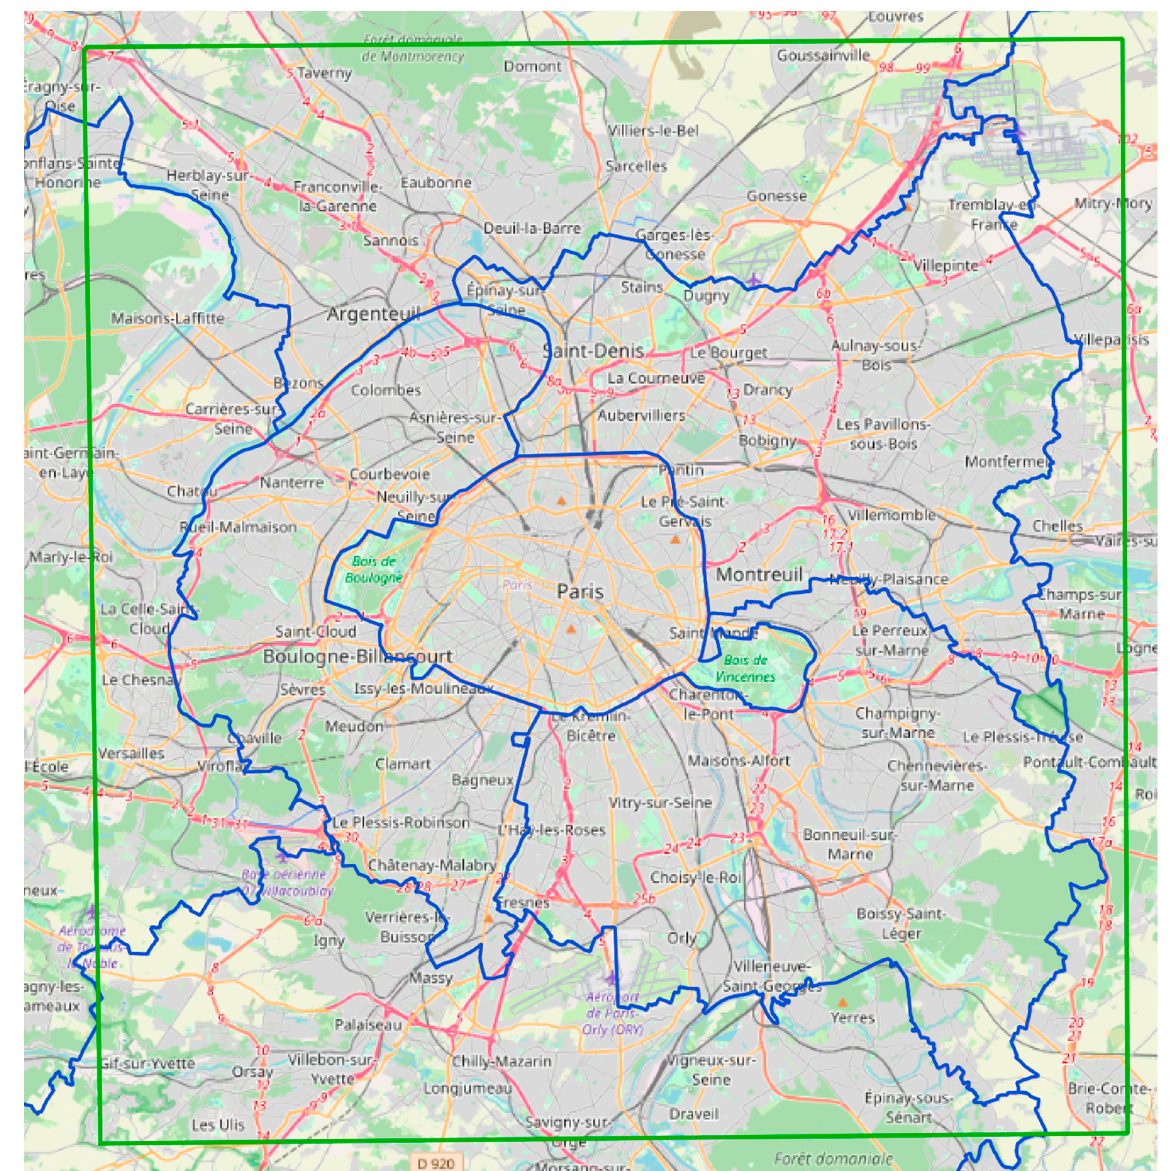
Figure 2. View of the domain boundaries (green line) and the department boundaries (blue line) (© OpenStreetMap Con- Figure 2. Viewofthedomainboundaries(greenline)andthedepartmentboundaries(blueline)(© tributors).